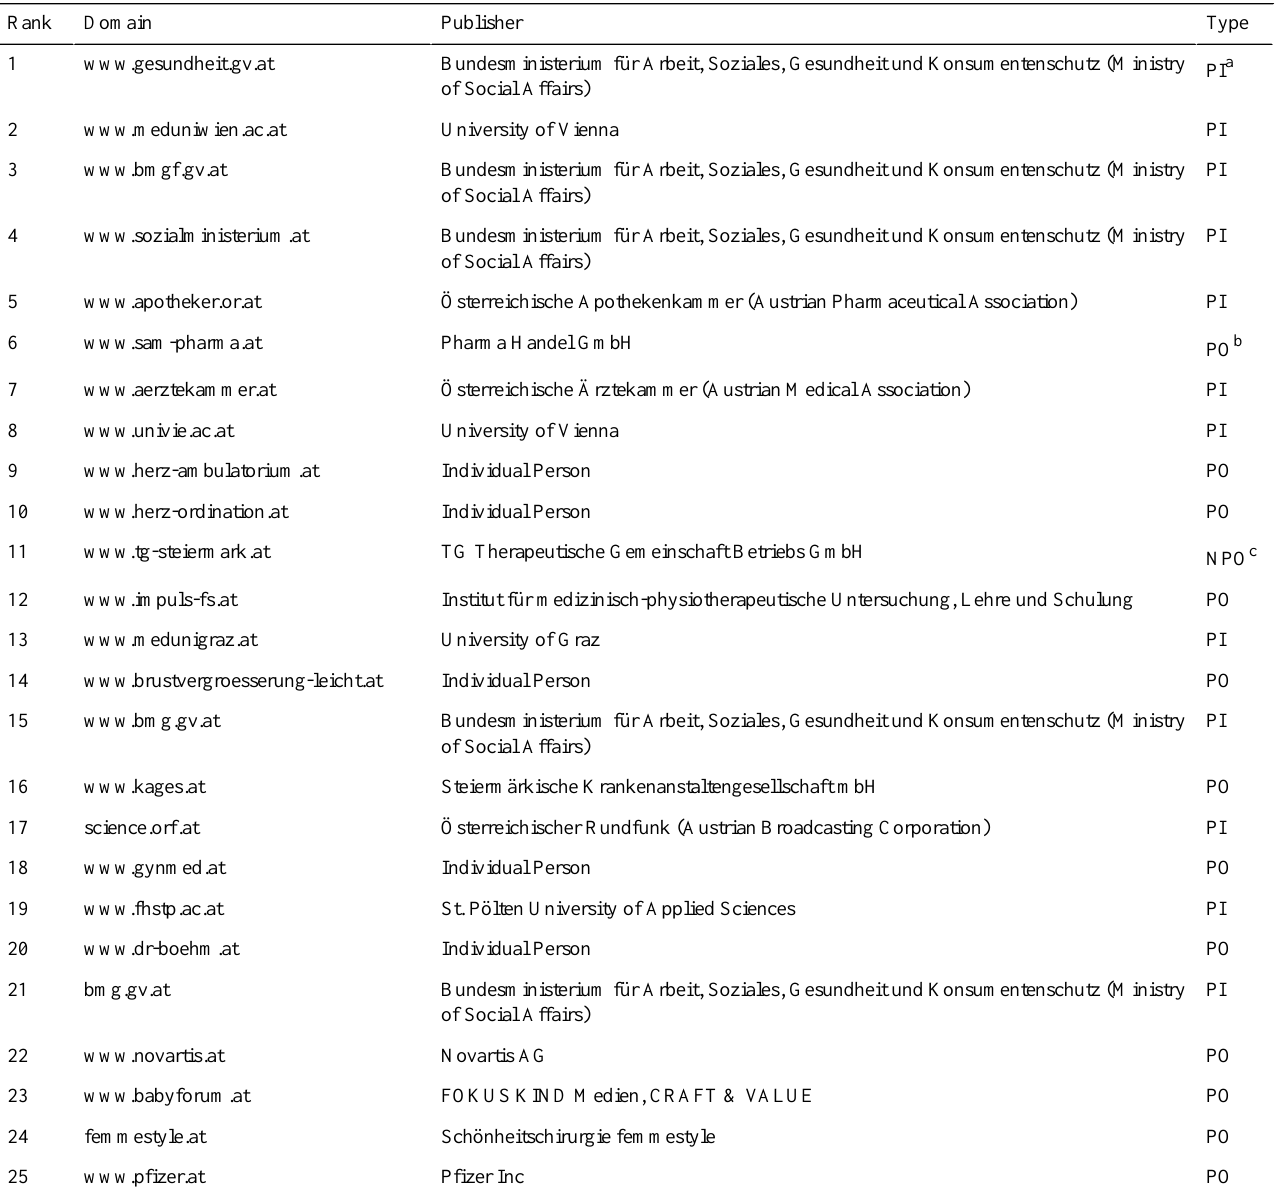
Table 5. Domains of 25 top-ranked web sites for country-code top-level domain .at with their respective publisher according to PageRank.